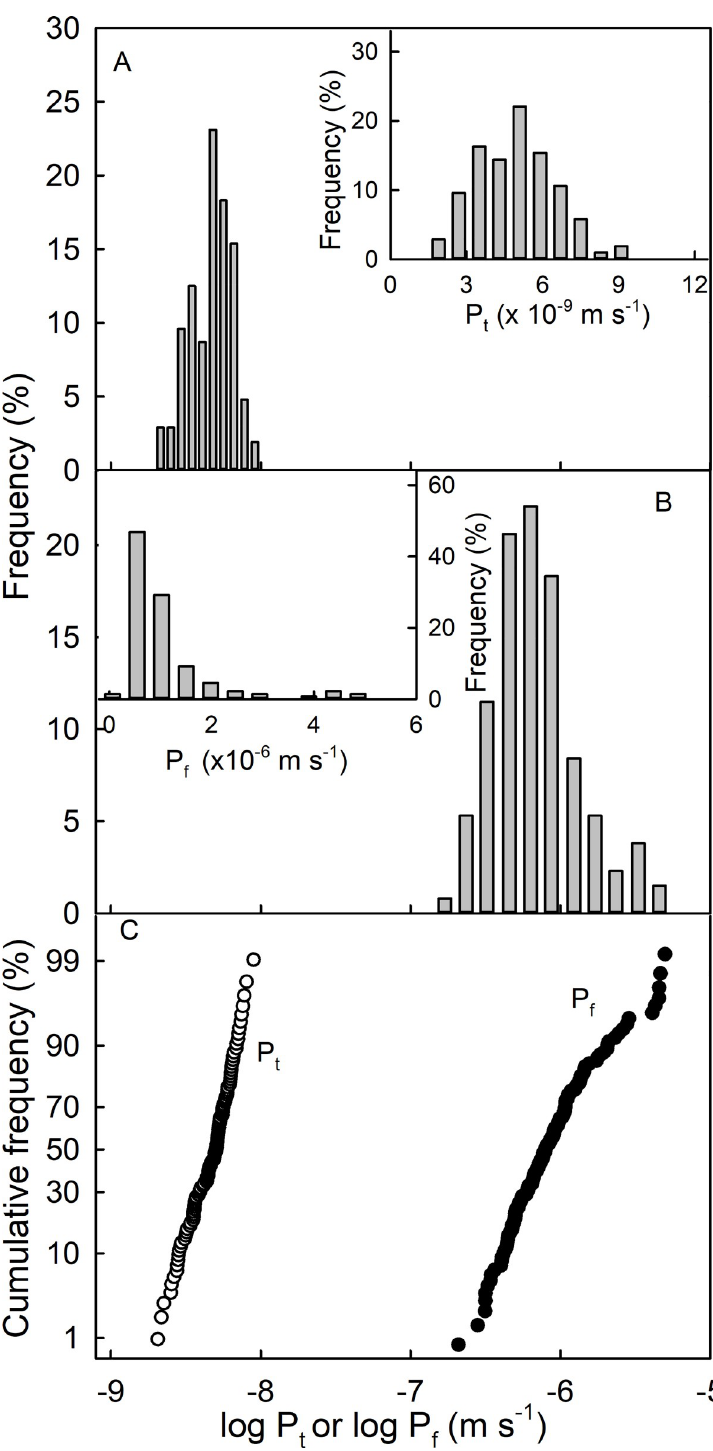
Fig 5. Frequency distributions of skin permeances of strawberries. (A) Log-transformed permeance for transpiration (P t ) (main graph) and un-transformed P t (inset). (B) Log-transformed permeance for osmotic uptake (P f ) (main graph) and un-transformed P f (inset). (C) Normal probability plot of the log-transformed permeance of P t and P f